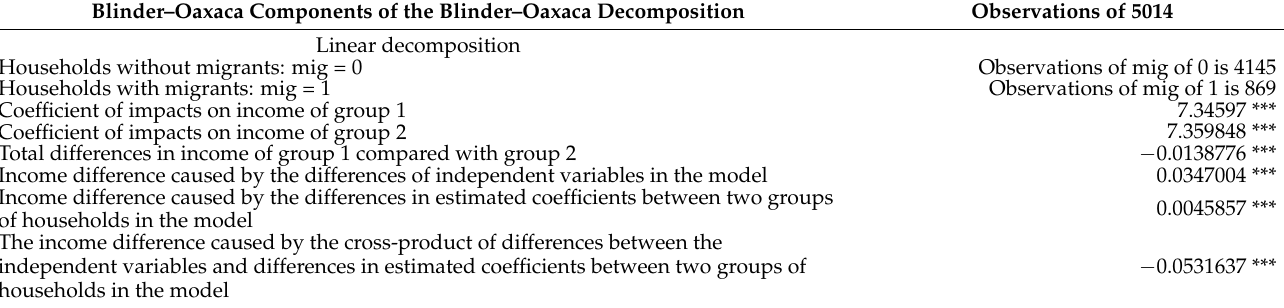
Table 1. Results of the Blinder–Oaxaca decomposition.